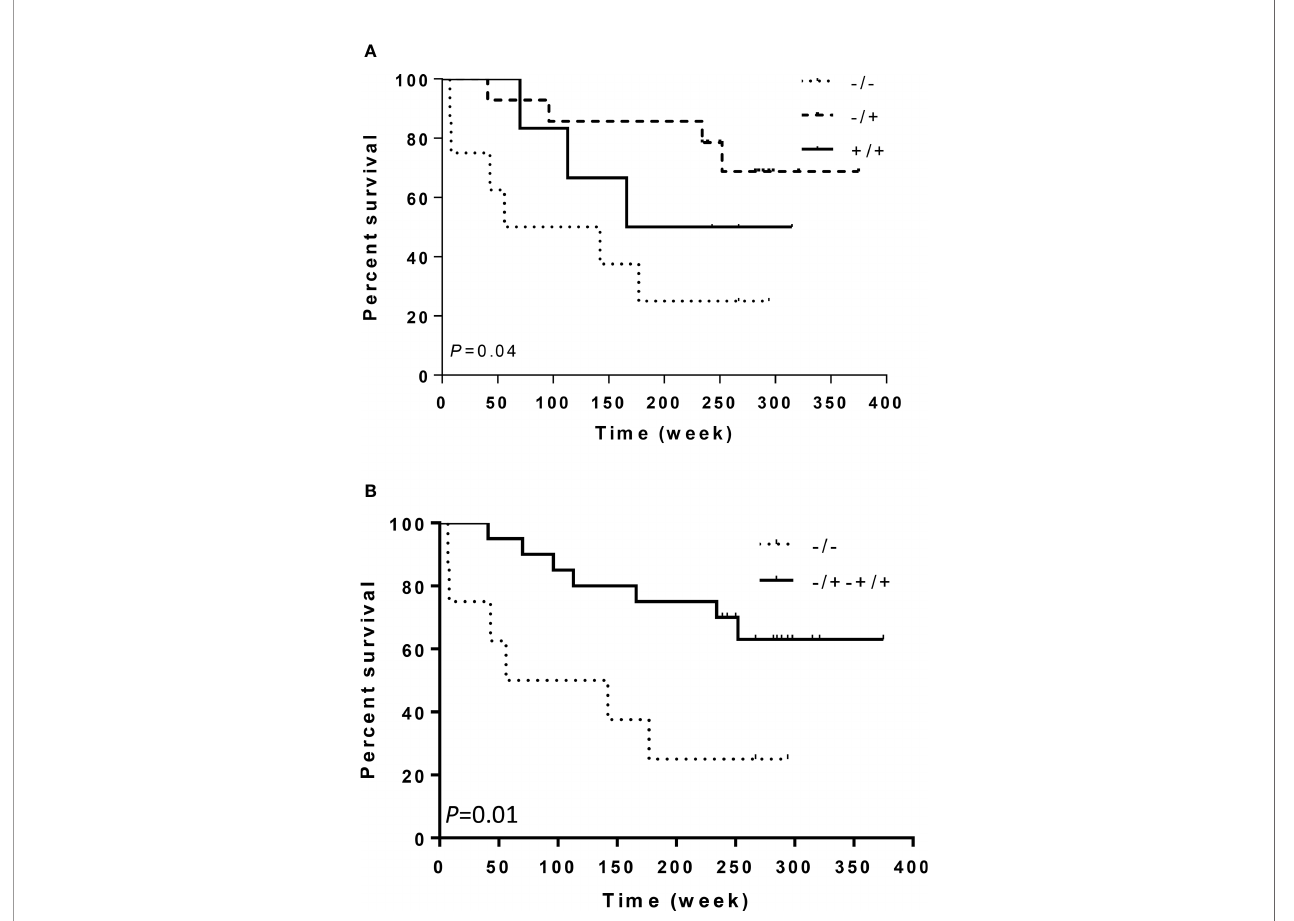
FIGURE 3 | Kaplan – Meier curves of survival related to ITGA2 polymorphisms in 28 patients with astrocytoma grade II. Patients with ITGA2 -/- had a poorer prognosis than patients with (A) ITGA2 +/+ or (B) ITGA2